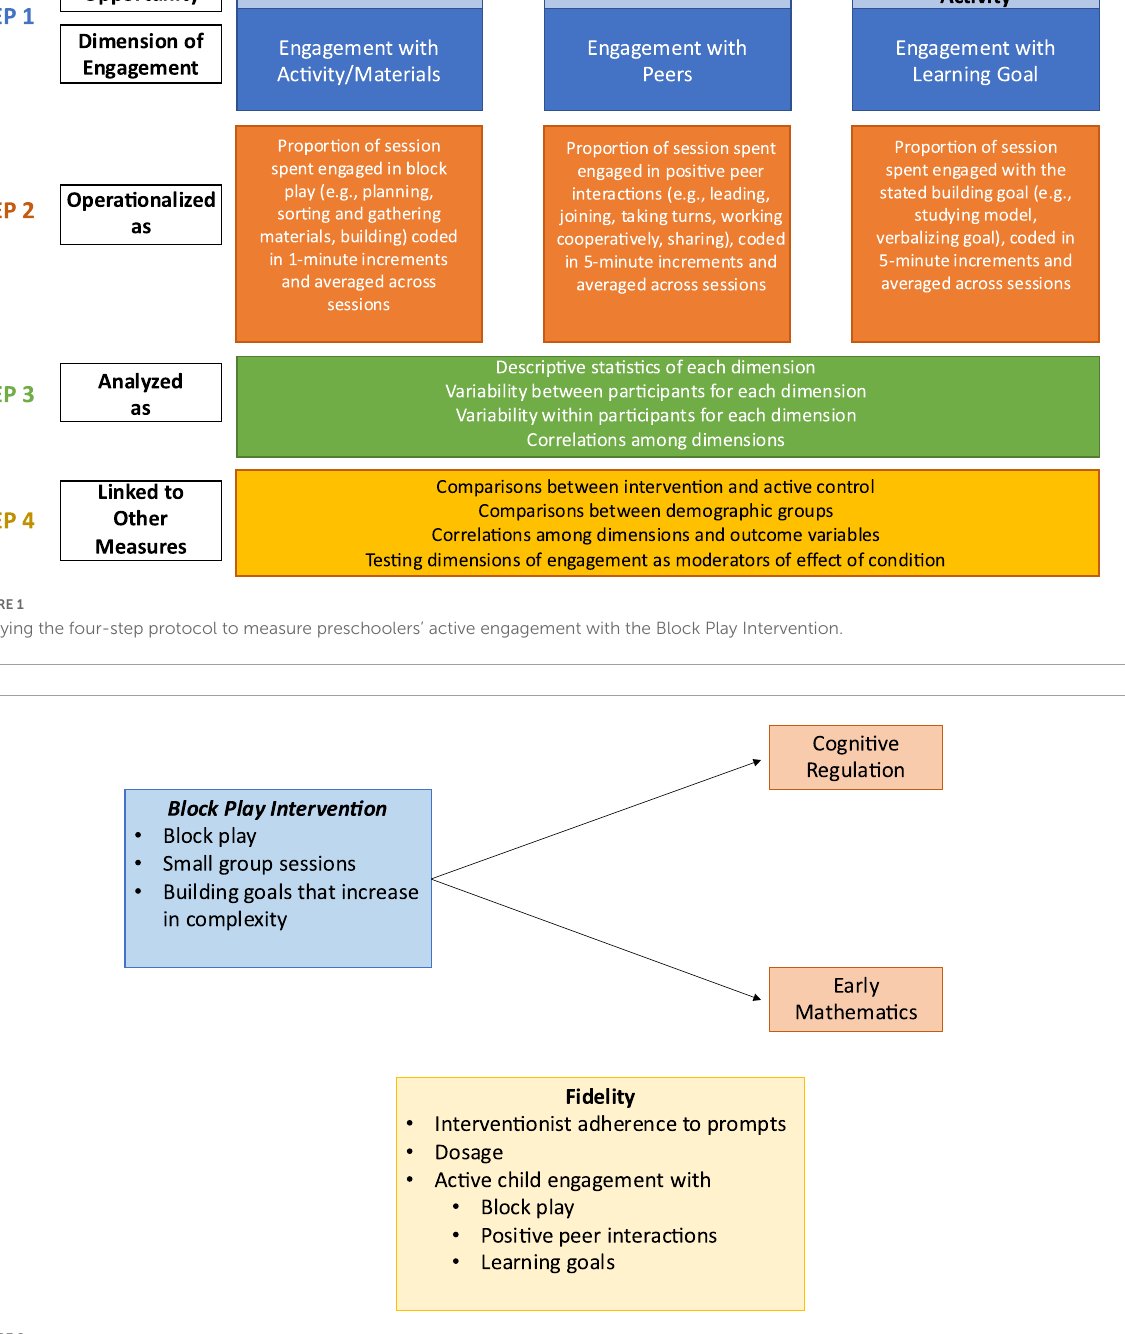
FIGURE2 Theory of change for the Block Play